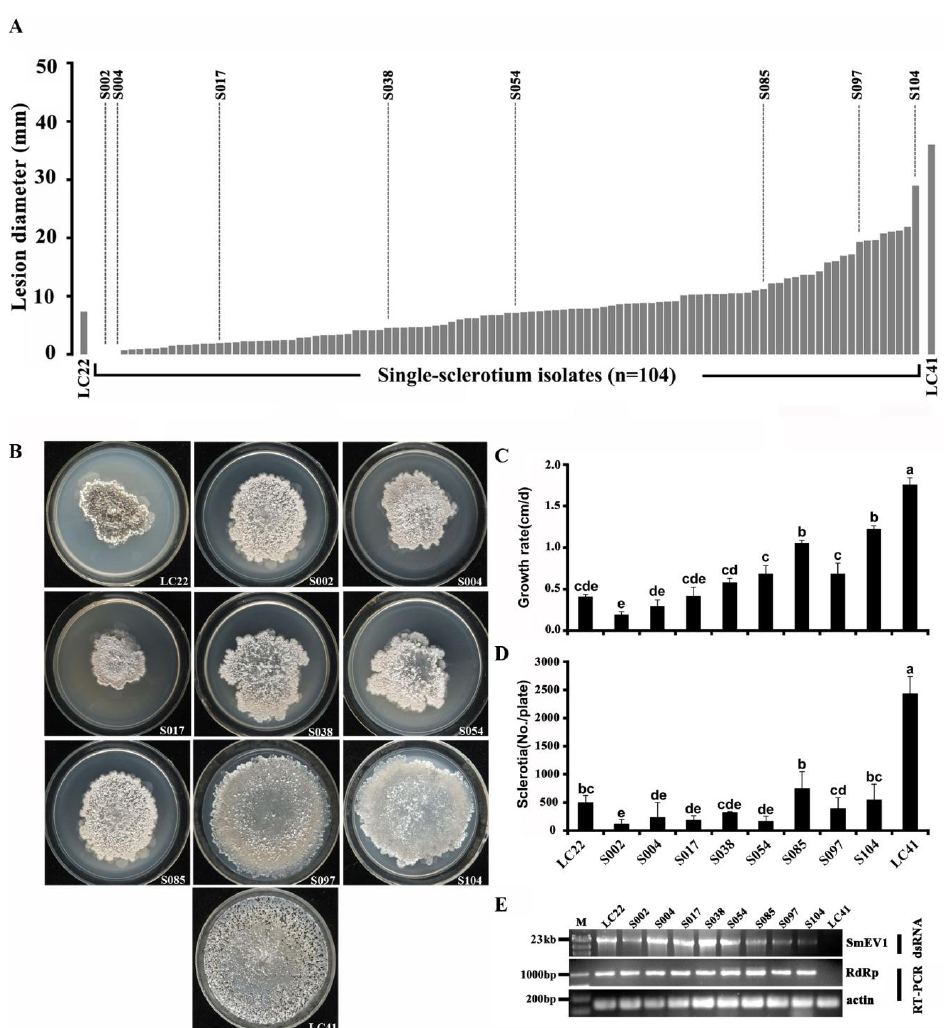
Figure 4. Transmission of SmEV1 in strain LC22 of Sclerotinia minor through sclerotia. ( A ) A histograph showing the average lesion diameters caused by the hypovirulent strain LC22, 104 single-sclerotium (SS) isolates of strain LC22 and the virulent strain LC41 on detached leaves of oilseed rape (20 °C, 72 h). Note reduced average leaf lesion diameters caused by strain LC22 and its SS progenies, compared to the lesion caused by LC41. Eight representative SS isolates selected for further analyses were labeled in the graph; ( B ) Colony morphology of LC22, eight SS isolates and LC41 (PDA, 20 °C, 30 d); ( C ) Average growth rates ( n = 5) for LC22, eight SS isolates and LC41. Different letters on the bars in each graph indicate significant difference ( p < 0.05) according to the Least Significant Difference test; ( D ) Average sclerotial yield ( n = 5) produced by LC22, eight SS isolates and strain LC41 in 30-day-old PDA cultures; ( E ) Detection of SmEV1 in LC22, eight SS isolates and LC41 by dsRNA extraction and